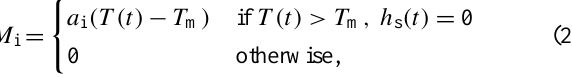
Figure 2. Sketch of the flow paths from a catchment with five source areas A j and three channels C j . The notation C ∗ injection into this channel is not concentrated at the upstream end but, in theory, randomized and integrated over the channel length (Bras and Rodriguez-Iturbe, 1985). In practice, we take half of the channel